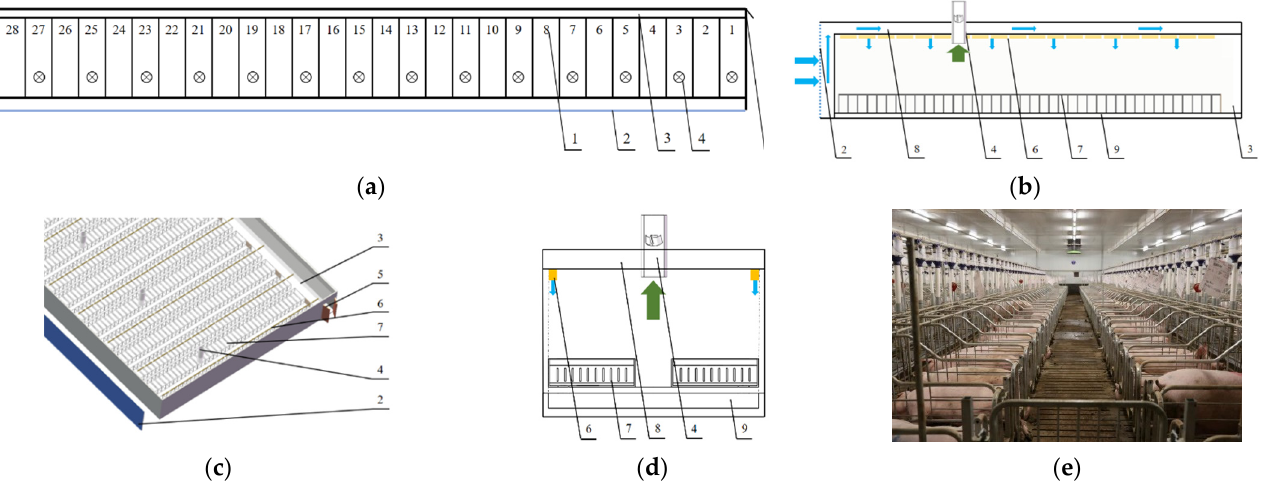
Figure 1. Pregnant sow piggery layout: ( a ) piggery plane graph; ( b ) piggery air distribution profile; ( c ) graphic model of piggery interior; ( d ) schematic diagram of piggery transverse section; ( e ) transverse section image of piggery. Note: 1. number of pregnancy units; 2. wet curtain; 3. aisle; 4. frequency conversion fan; 5. door; 6. air intake; 7. limit column; 8. ceiling cavity; 9. manure pit.